Question: Express in one sentence what the figure is showing.
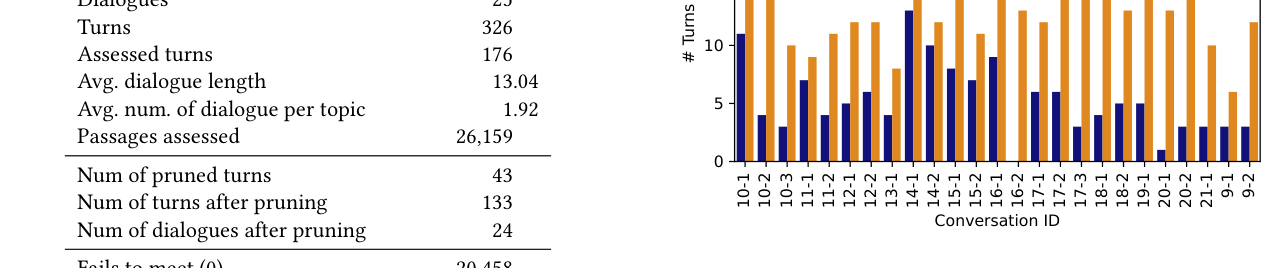
Answer: Number turns evaluated per dialogue in the final judgment pool vs. the maximum depth of each topic.